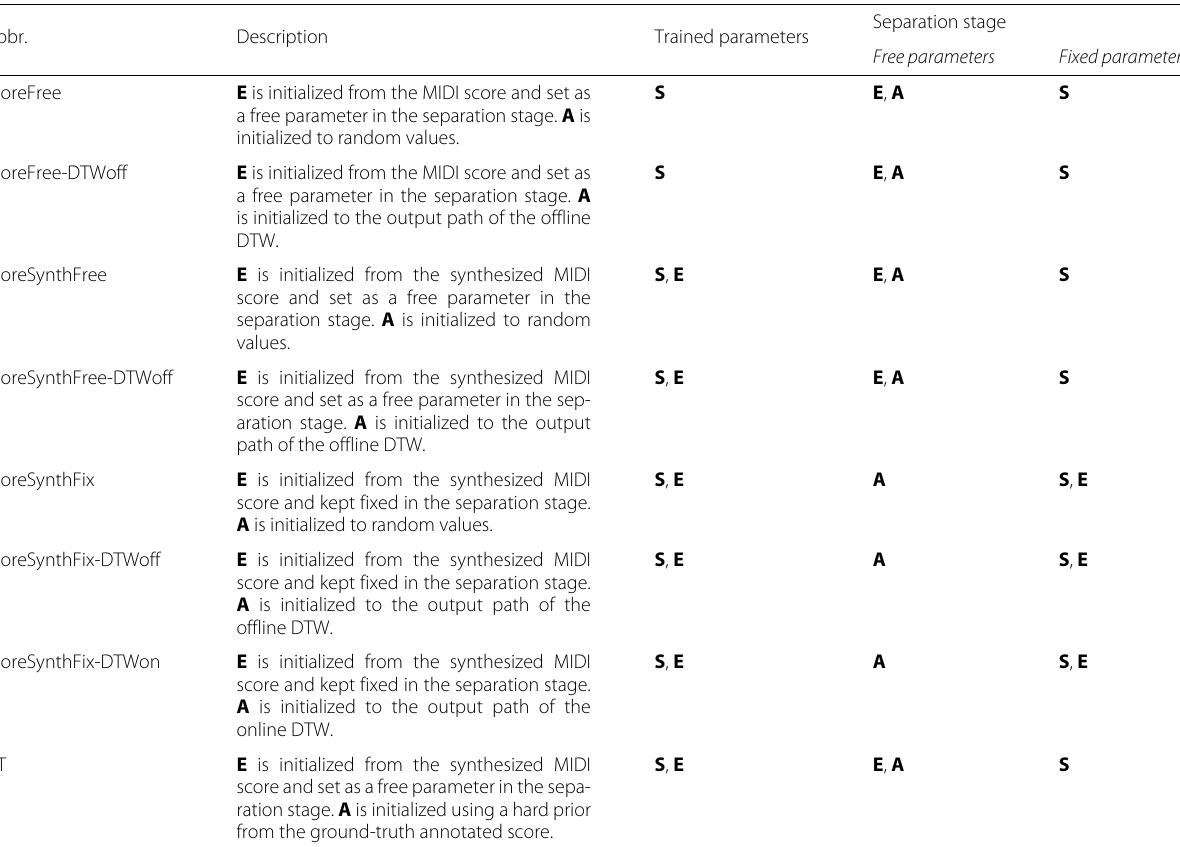
Table 3 Algorithm notation Abbr.